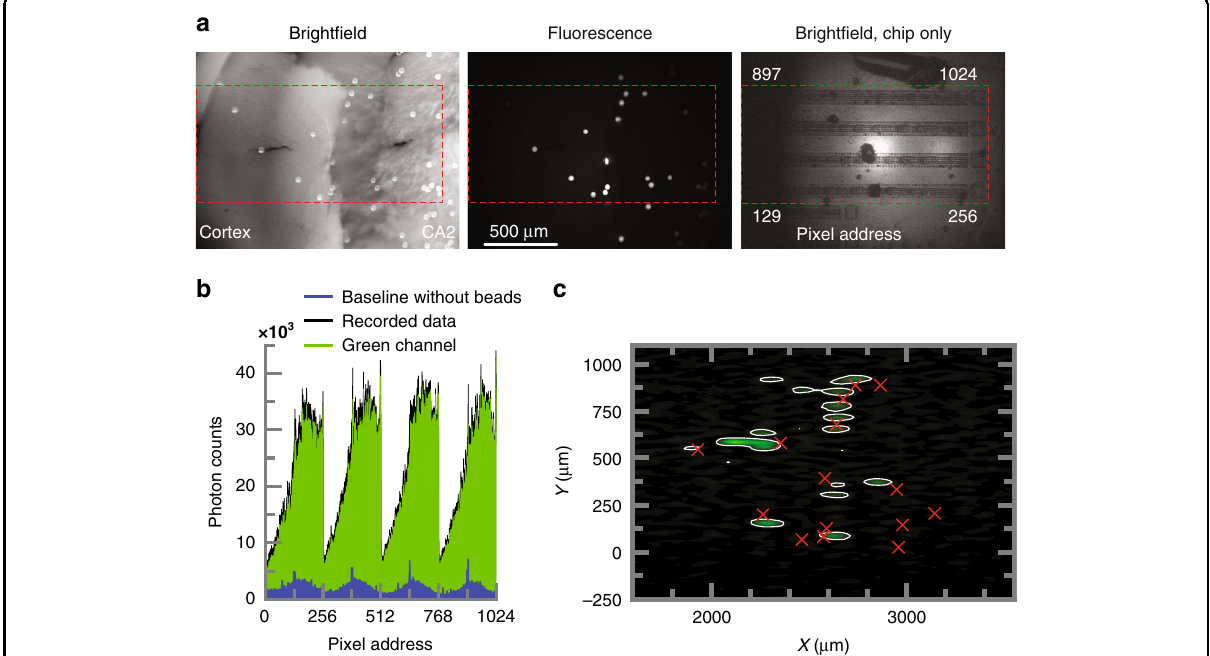
Fig. 6 Ex-vivo recording. a Bright fi eld image of the whole brain slice laminated over the chip. The fl uorescence image reveals the beads distributed through the tissue. Bright fi eld image of the location over the chip. b Recorded data, plotted alongside the background recorded for illumination of brain slice in the absence of beads. c Inverse image of the data recorded, compared to the true locations denoted by red crosses. The contour is drawn around all values corresponding to 10% of the maximum value of the